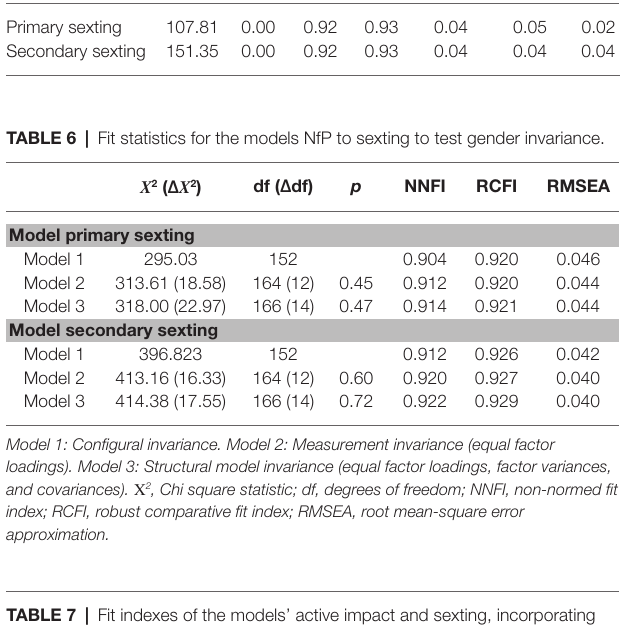
TABLE 5 | Fit indexes of the models Need for Popularity to sexting.